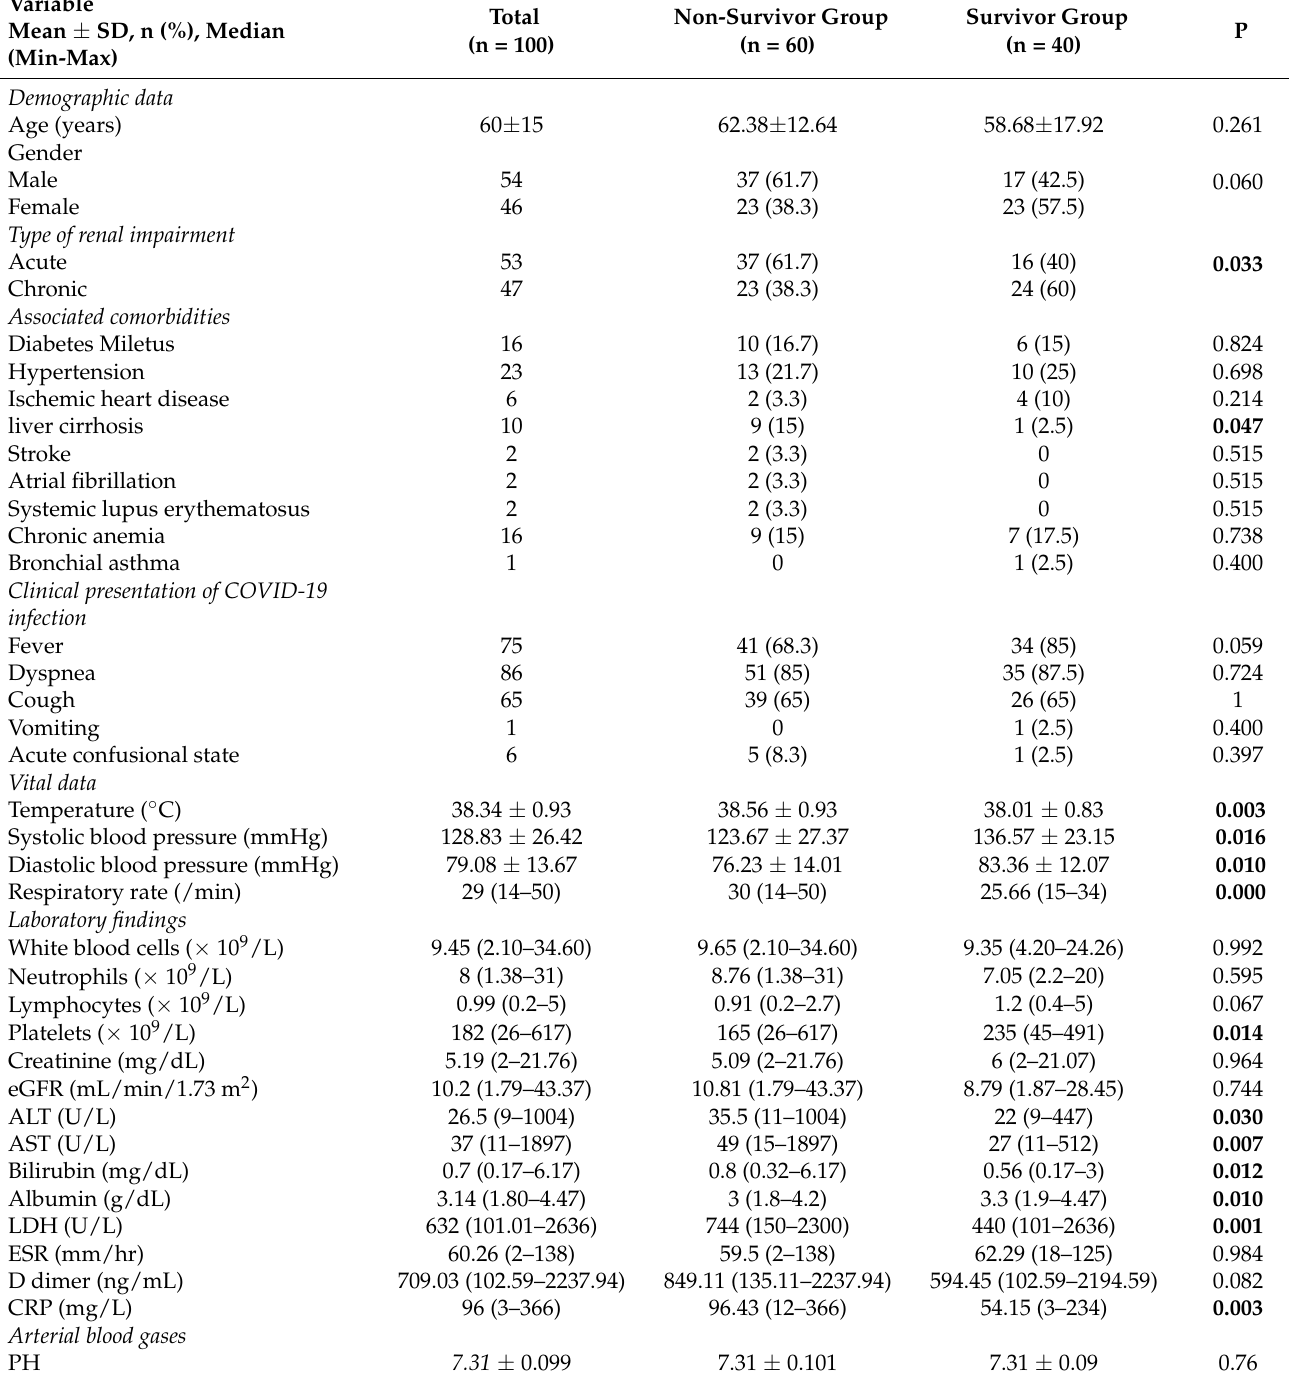
Table 1. Demographic, clinical and laboratory characteristics of the study population (n = 100); difference between survivor and non-survivor